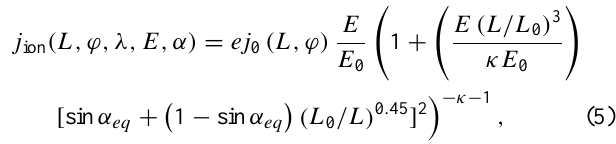
Figure 3. Fig. 3. Geometry of the detectors of the NUADU instrument. (Left), definition of the field of view of a single detector; (Right) pointing directions of all 16